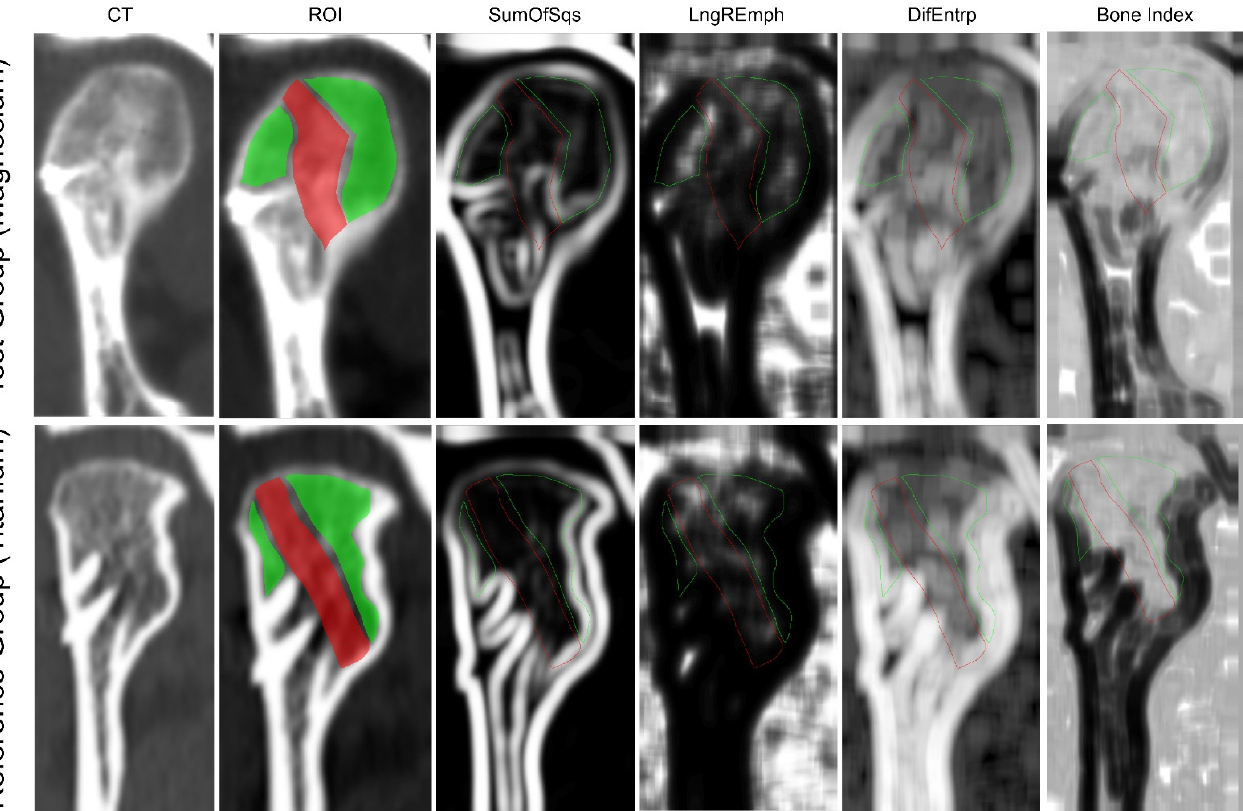
Figure 3. Examples of bone union after 12 months from osteosynthesis in the Magnesium and Titanium group observed by computed tomography (CT) mapping of regions of interest for texture analysis (ROI red: post-fracture site; green: control cancellous bone in the mandible head). The results of calculating the sum of squares of optical densities over a distance of two pixels (SumOfSqr), the frequency of long chains of pixels of similar optical density (LngREmph), the differential entropy in the image (DifEntrp), and the Bone Index were mapped.